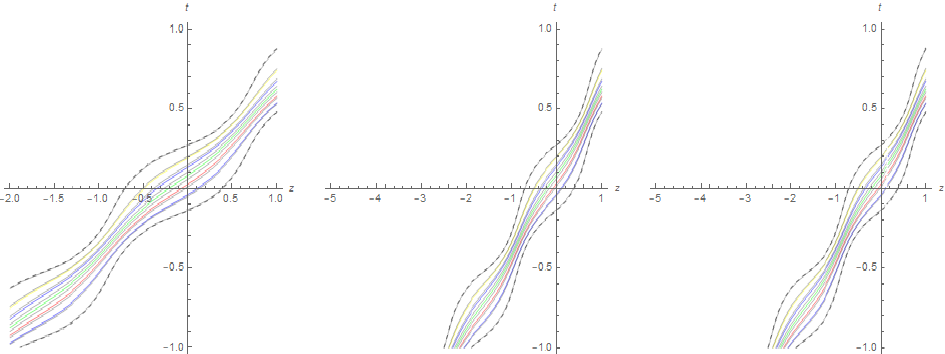
Figure 10. Contour graphs for Figure